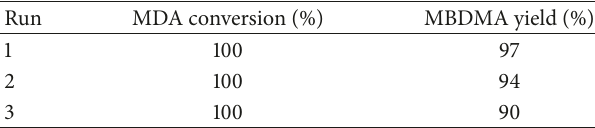
Table 4: Reuse of NaY zeolite catalyst.